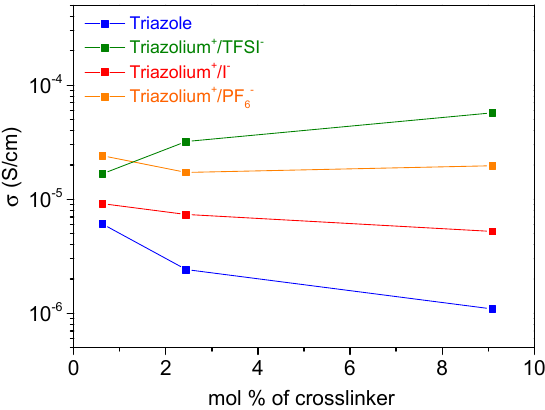
Figure 7. Conductivity values of each gel as a function of the molar percentage (mol %) of crosslinker. The cells are composed of stainless steel | PTMA gel swollen with EC:DEC (1:1) | stainless steel.